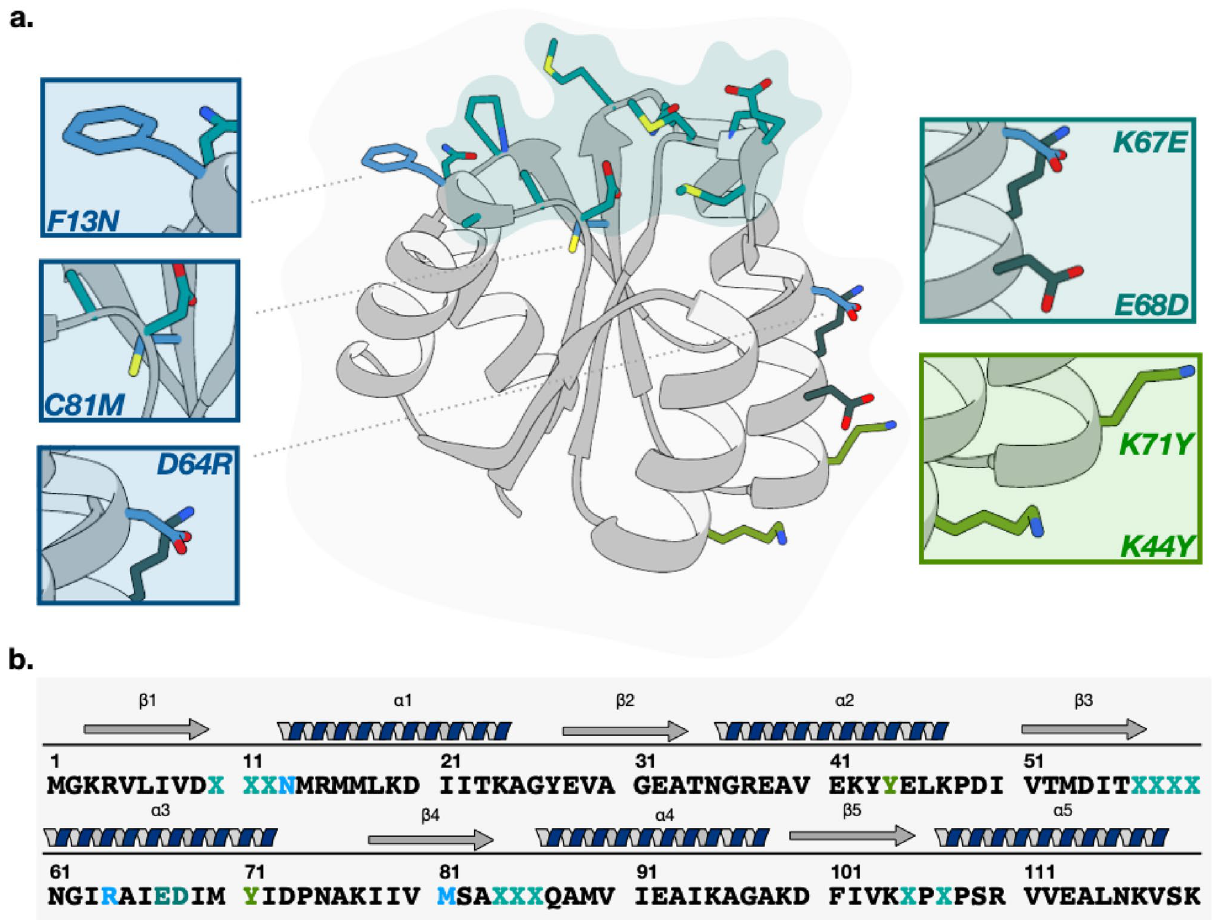
Figure 1. Design of the Cheytins Library. ( a ) The 3D XRay-structure CheY (pdb: 2TMY): a scaffold to design a novel library. The backbone corresponding to the constant residues is represented in grey. The randomized residues are displayed in cyan stick in the four exposed loops. The corresponding surface is also highlighted in cyan. The mutations R13N, D64R, C81M corresponding to the stability of the scaffold are shown in light blue stick. The two mutations K67E and E68D corresponding to the insertion of BbsI restriction sites in the CheytinWT are represented in dark green stick and the mutations K44Y and K71Y are shown in light green. ( b ) Amino acid sequence of the CheytinWT with residues represented with the same colors as in the structure. Randomized positions are represented by a blue cross in position 10, 11, 12, 57, 58, 59, 60, 84, 85, 86, 105,